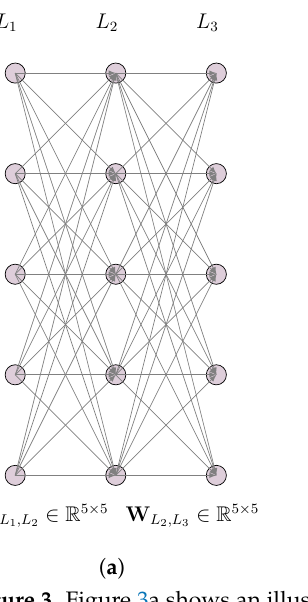
Figure 3. Figure 3a shows an illustration of FC layer and its connections. Figure 3b highlights the connections of one neuron with its previous and next layer. ( a ) Fully Connected Layer; ( b ) Connections of one node in FC